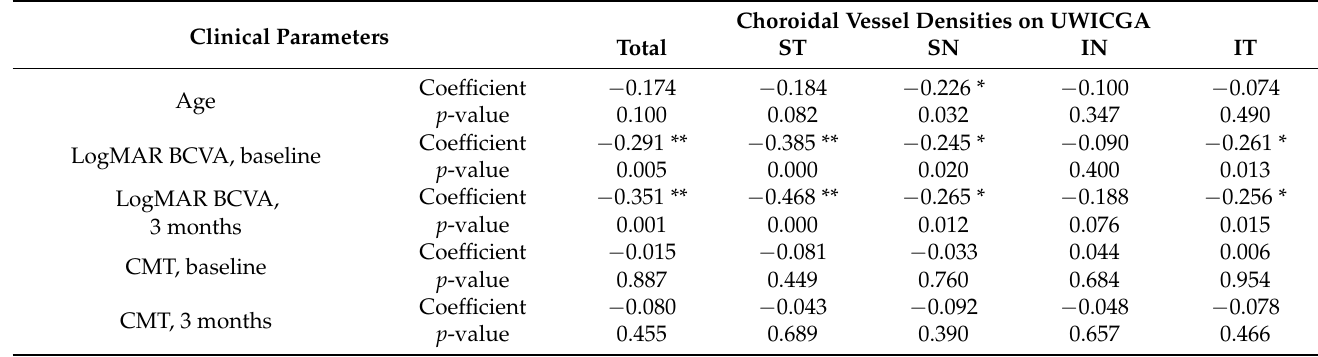
Table 3. Correlation between clinical parameters in pachychoroid neovasculopathy.